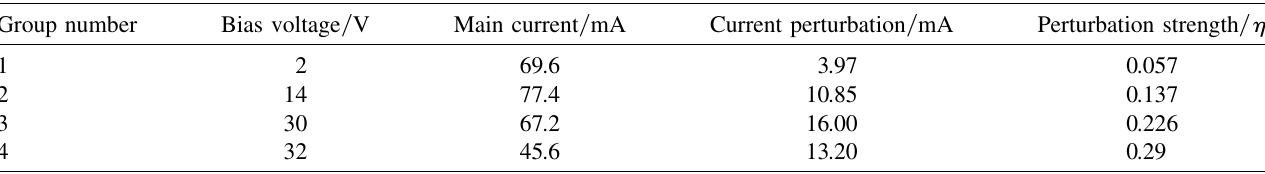
TABLE I. Data for current perturbation generation at the